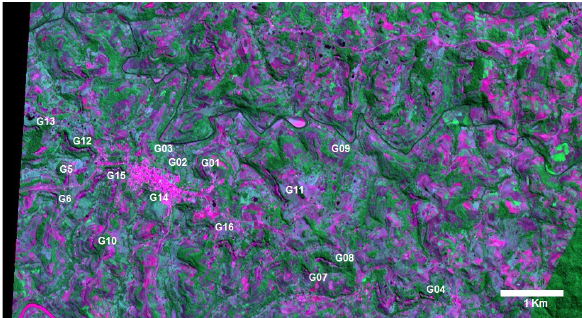
Figure 2. Aster scene color composition R(2), G(3), B(1) with the amethyst mining points distribution.